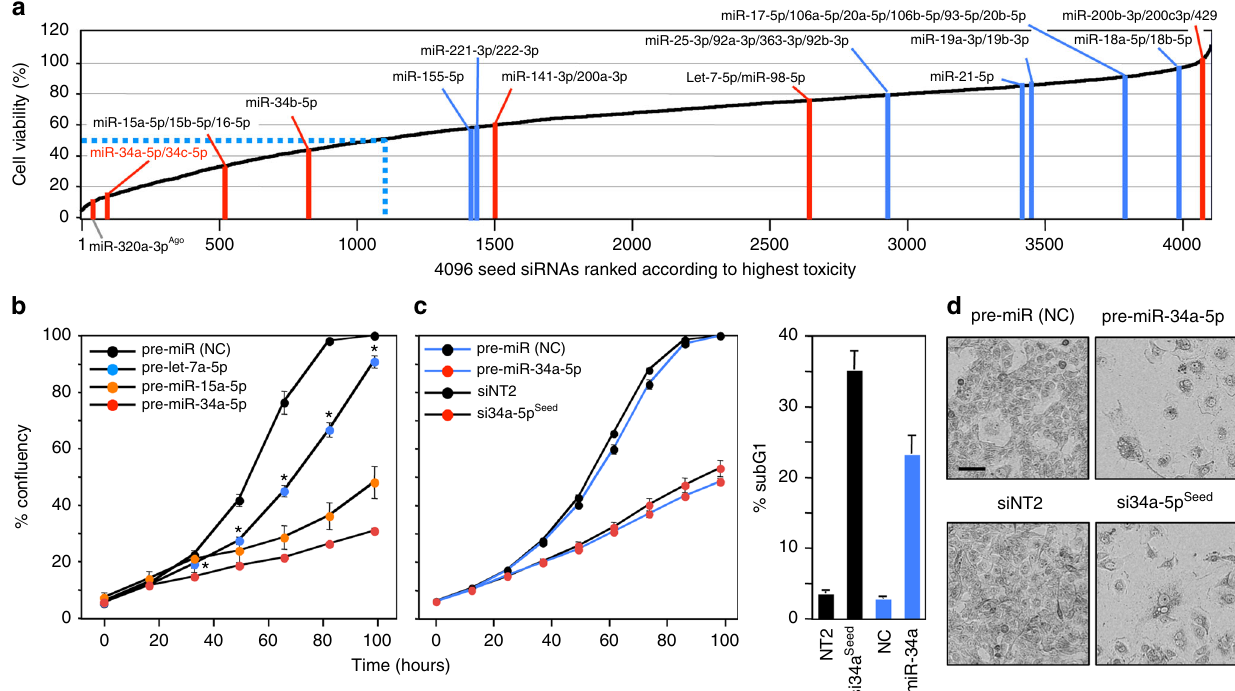
Fig. 4 Tumor-suppressive miRNAs inhibit cancer cell growth via toxic 6mer seeds. a All 4096 6mer seeds ranked from the lowest average viability (highest toxicity) to the highest viability (lowest toxicity) according to the average of HeyA8 and H460 cells. Locations of 6mer seeds present in major tumor- suppressive (red) or tumor-promoting (blue) miRNAs are highlighted as individual bars. miRNAs are considered to be toxic when viability is inhibited >50% (blue stippled line). b Percent cell con fl uence over time of HeyA8 cells transfected with 5 nM of either the indicated tumor-suppressive miRNA precursors or an miRNA precursor non-targeting control. Data are representative of two independent experiments. Each data point represents mean ± SE of four replicates. *Two-way ANOVA p -value between cells treated with pre-miR-(NC) and pre-let-7a-5p is 0.0000. c Left: Percent cell con fl uence over time of HeyA8 parental cells transfected with either pre-miR-34a-5p or si34a-5p Seed and compared to their respective controls (pre-miR (NC) for pre-miR-34a- 5p and siNT2 for si34a-5p Seed ) at 10 nM. Data are representative of two independent experiments. Each data point represents mean ± SE of four replicates. Right: % cell death of the same cells harvested 4 days after transfection. Data are representative of two experiments. Each data point represents mean ± SD of three replicates. d Morphology of HeyA8 cells transfected with 10 nM of either pre-miR-34a-5p or si34a-5p Seed compared to their respective